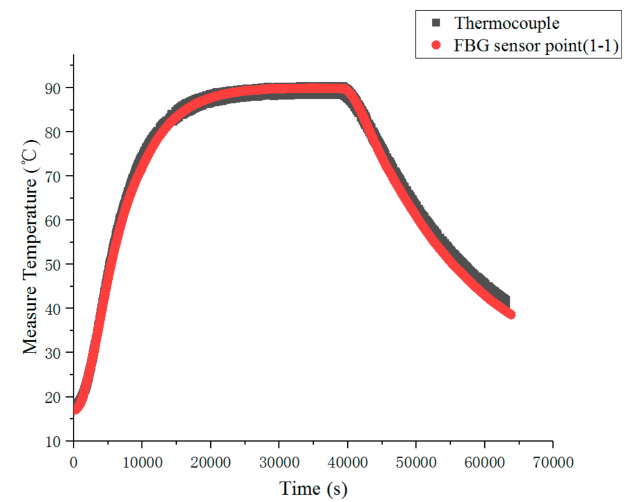
Figure 13. Comparison of measurement results of the thermocouple and measuring point 1-1 of FBG sensor.